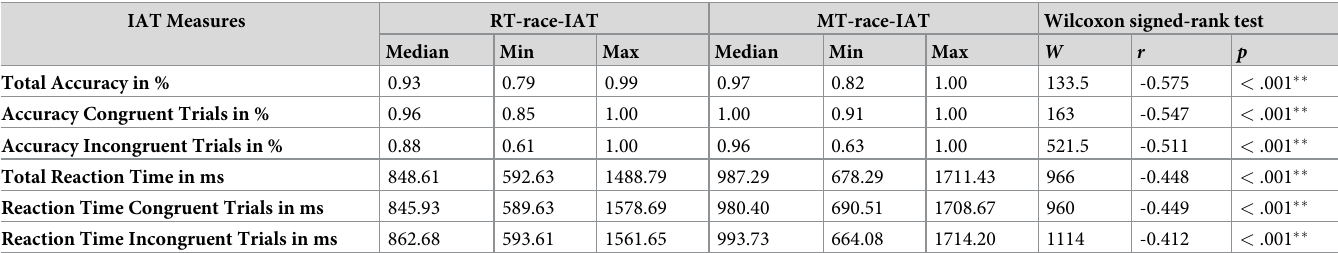
Table 2. RT- vs MT-race-IAT accuracy and reaction times